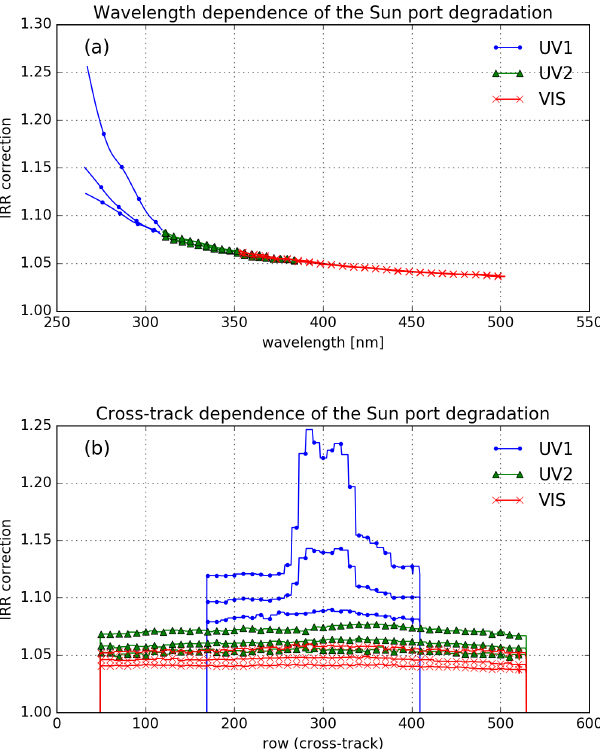
Figure 7. Observed degradation of the Sun port for mission year 17. The UV1, UV2, and VIS channels are plotted in blue dots, green triangles, and red crosses, respectively. Panel (a) shows the wave- length dependence for three rows and panel (b) the row dependence for three selected wavelengths in each